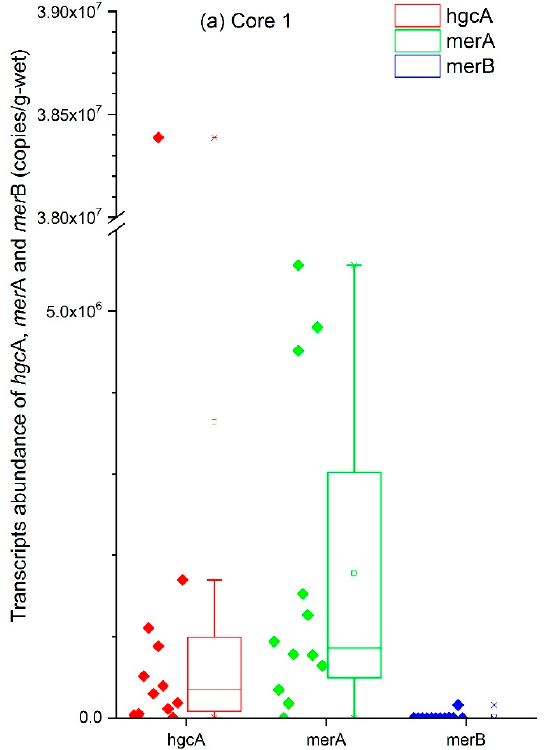
Table 3. 16S rRNA copy numbers in three